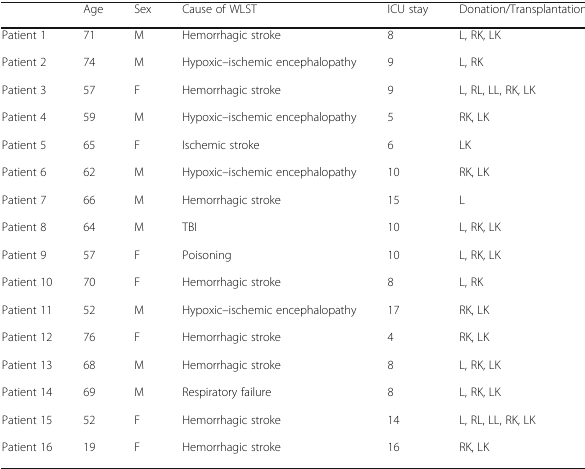
Table 1 (abstract 001036). WLST, withdrawal of life ‐ sustaining therapy; ICU, intensive care unit; M, Male; F, Female; TBI, traumatic brain injury; L, liver; RL, Right Lung; LL, Left Lung; RK, Right Kidney; LK, Left